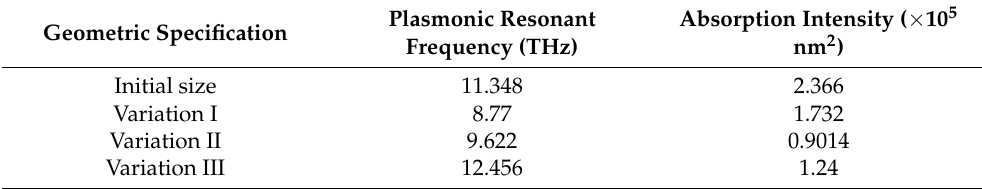
Figure 4. ( a )The influence of geometric variation of ribbons on ACS of the perfect absorber, ( b ) the effect of changing in the width of graphene stripline layer on ACS of the absorber. Table 3. Variations of absorption characteristics due to size manipulations.